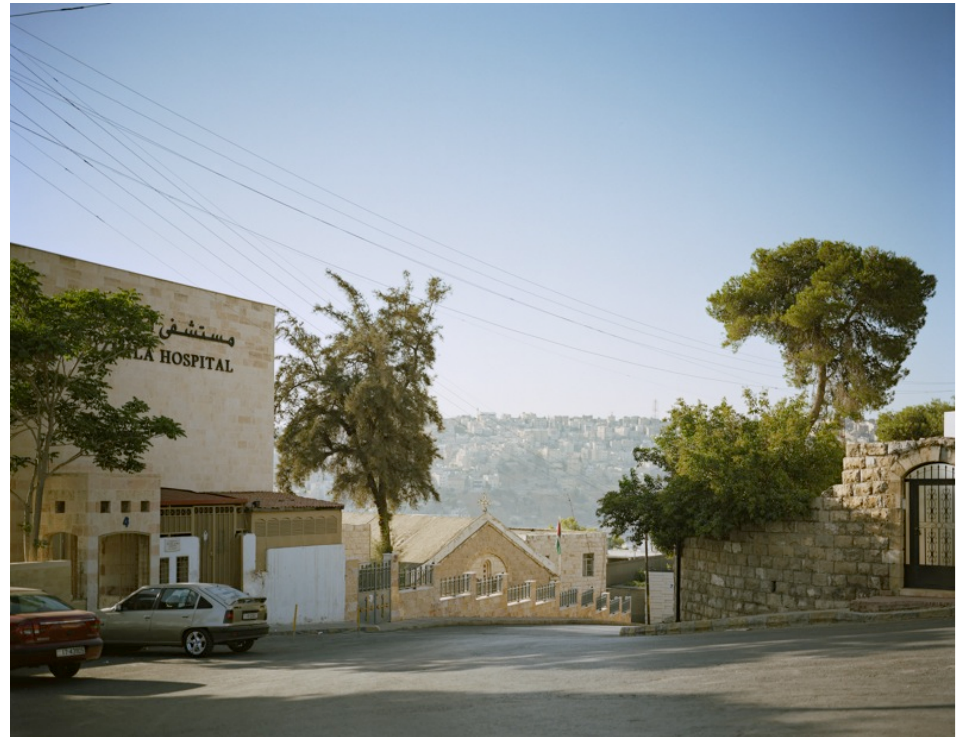
Regina Mamou, Untitled (Luzmila Hospital) from the series Mapping Collected Memory , 2009–2010. Digital C-print. 40 x 50 in. (101.60 x 127